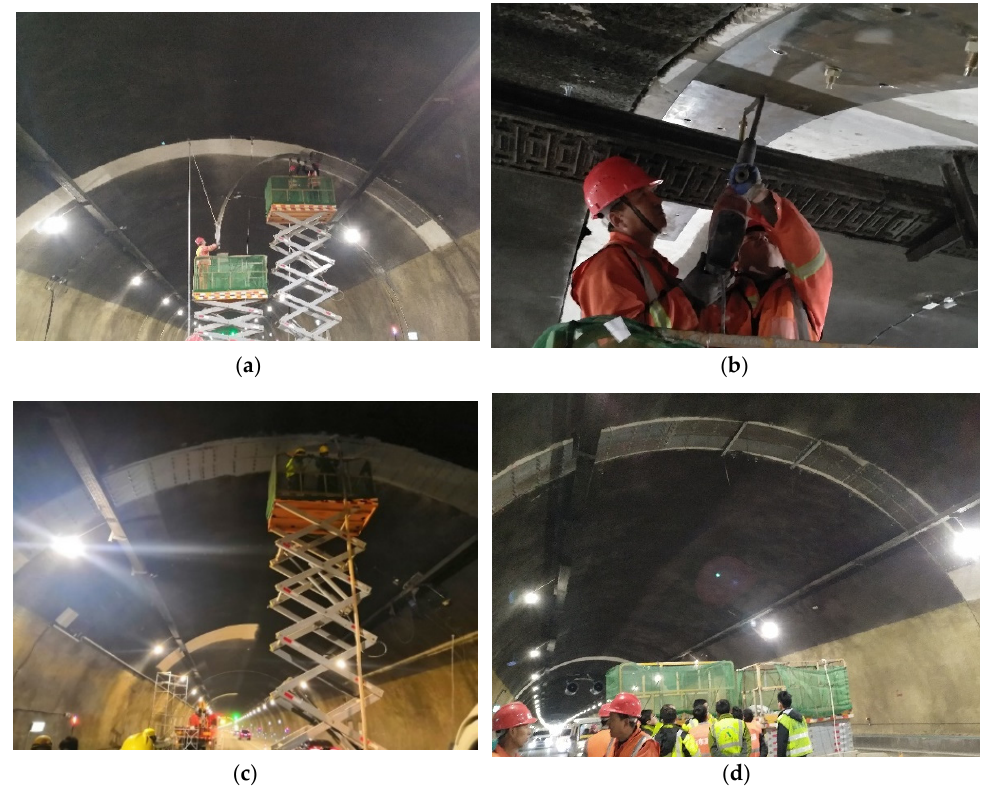
Figure 2. Installation of the steel plate. ( a ) Hoisting steel plate; ( b ) drilling; ( c ) installation of anchor bolts and adhesive layer; ( d ) final installed plate.